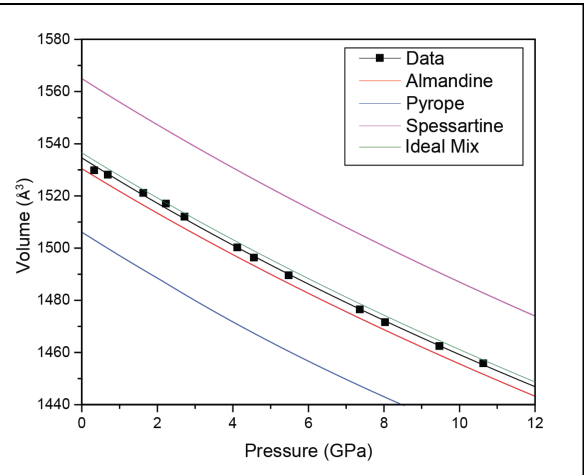
Figure 1. Pressure-volume data for the Alm 74 Sps 13 Prp 10 Grs 3 garnet analyzed in this study with SXD plotted as black squares. Experimental errors are smaller than the data symbols. The black line is the third-order Birch-Murnaghan EoS fitted to the experimental data. EoS for end-member alman- dine [14], end-member pyrope [10], and end-member spessartine [13] are plotted for comparison. The green line is an EoS created using a weighted average of the V 0 , B 0 , and B (cid:48)